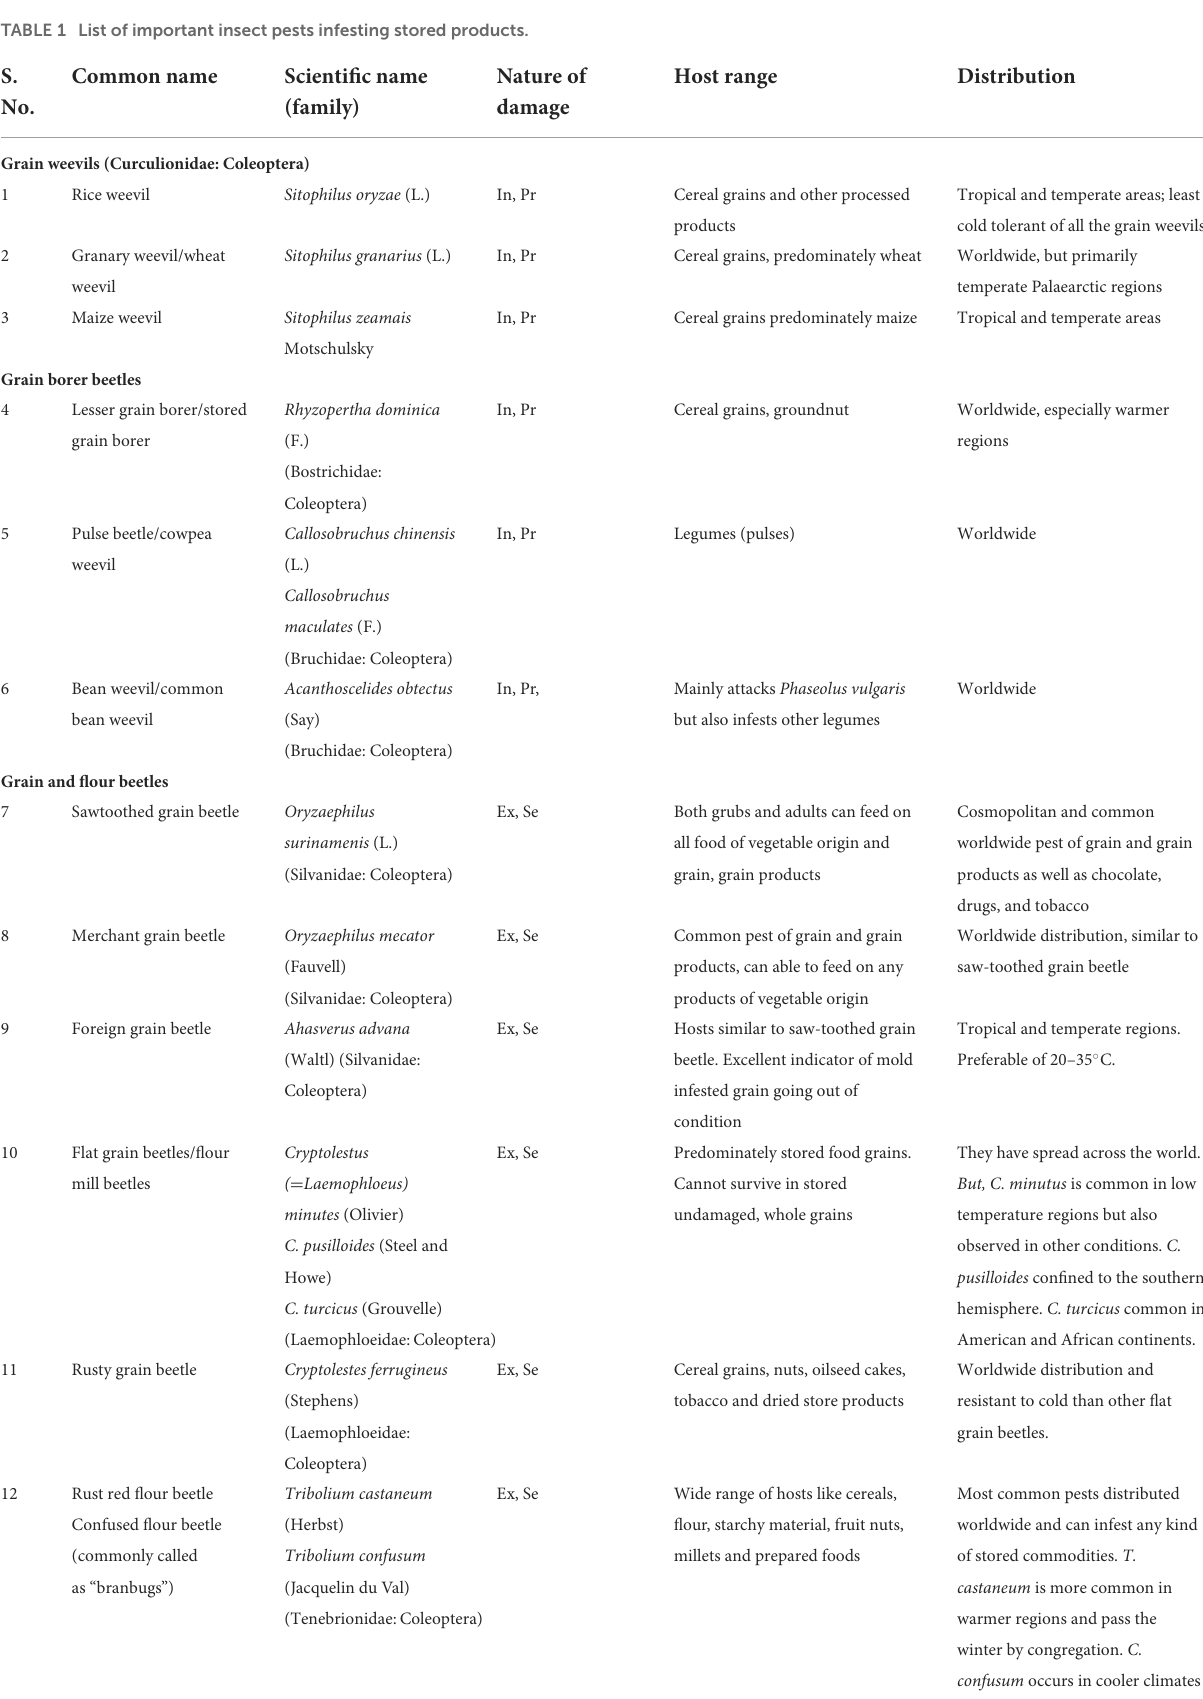
TABLE 1 List of important insect pests infesting stored